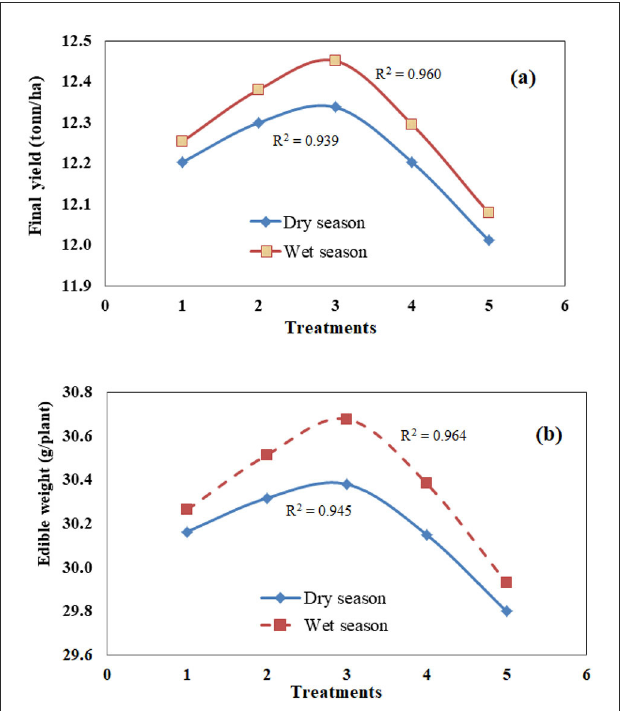
FIGURE5 Final yield (ton ha − 1 ) (a) and edible weight (g plant − 1 ) (b) of Malabar spinach ( Basella alba L.) vegetable fertilized with five different treatments for the two seasons.